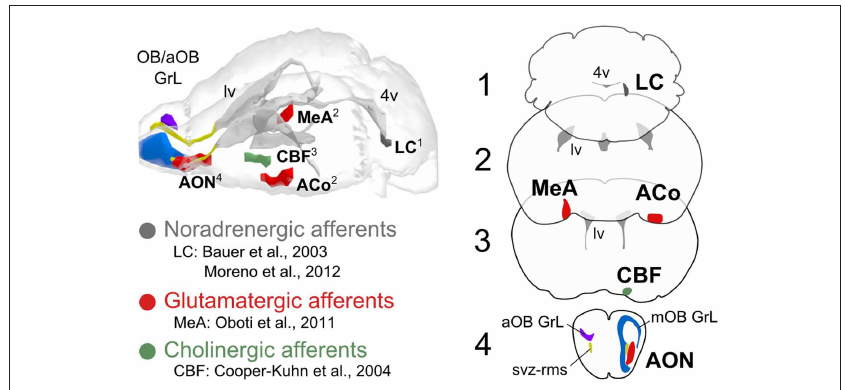
Figure 1 | Principal brain centrifugal afferents to the olfactory bulb. The modulatory role of noradrenergic, glutamatergic, and cholinergic brain afferents on neuronal survival in the olfactory bulb (main and accessory, mOB/aOB) has been reported by the studies indicated by the references. The projection sites of noradrenergic (locus coeruleus, LC), glutamatergic (medial, cortical amygdala, and anterior olfactory nucleus; MeA, ACo, AON), and cholinergic afferents (cholinergic basal forebrain, CBF) to the olfactory bulb are represented unilaterally in the brain model and in the coronal planes on the right, ipsilaterally to the targeted bulbar region (mOB/aOB). Other abbreviations used: svz-rms, sub-ventricular zone-rostral migratory stream; GrL, granular layer; lv, lateral ventricle; 4v, fourth